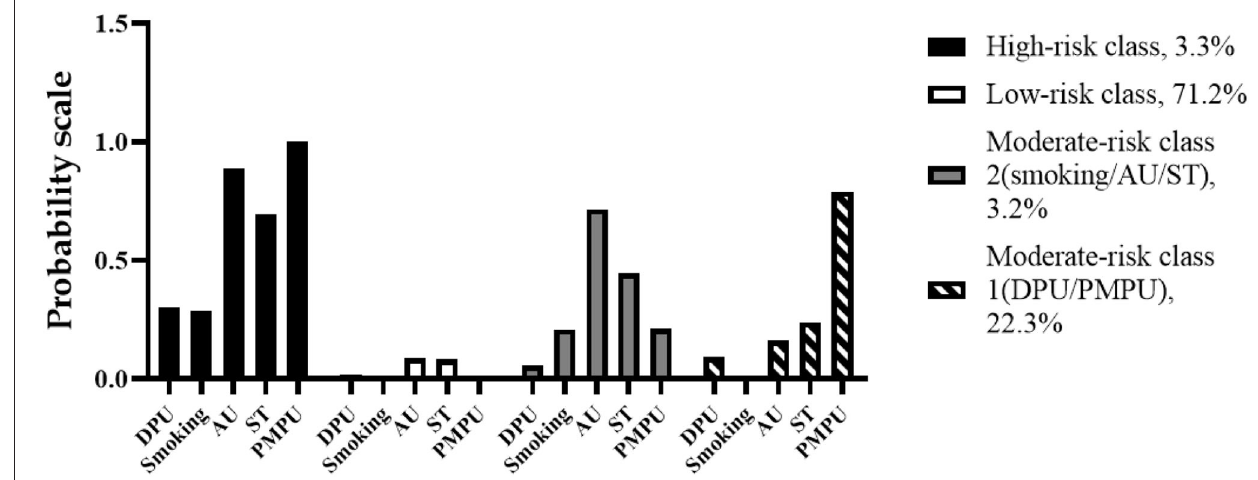
FIGURE 1 | The estimated probabilities of five behaviors among the four